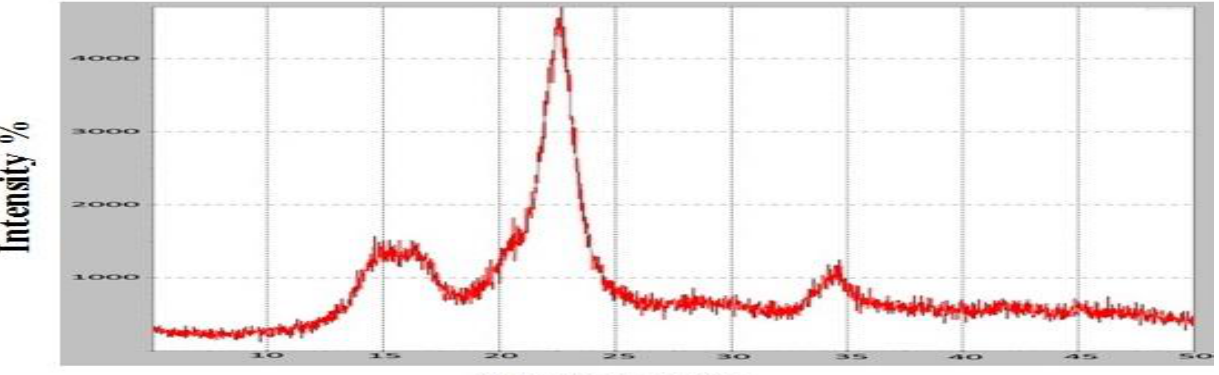
Figure 10. X-Ray diffraction of Avicel PH 102.